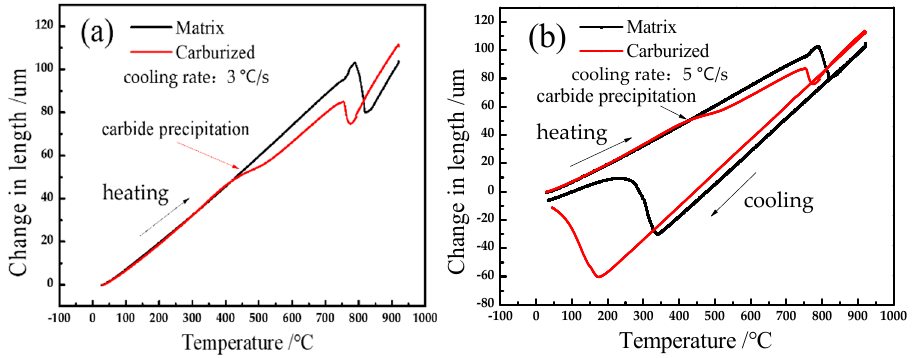
Figure 2. ( a ) Dilatometric curves of the carburised layer and the matrix at the heating stage, ( b ) dilatometric curve of the carburised layer and the matrix.